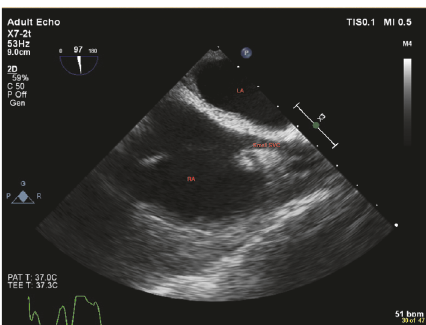
Figure 1: Midesophageal bicaval view showing small superior vena cava (SVC). RA = right atrium; LA = left atrium.